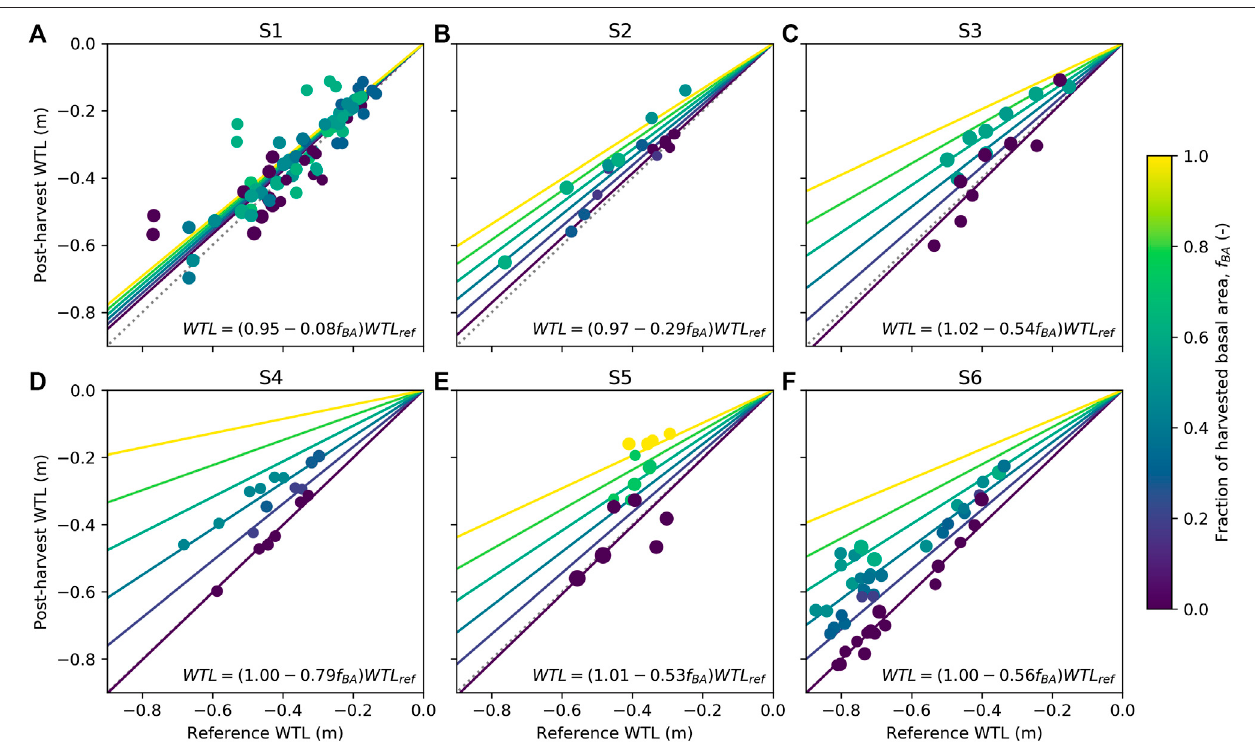
FIGURE5| Dependencyofpostharvestwatertablelevel(WTL)onreferenceWTL(see Eqs4and5 )forsitesS1 – S6 (A – F) .Thecolorsindicatetheharvestintensity andsymbolsizethepreharveststandbasalarea.DataarepresentedasmeanyearlyvaluesforJune – Octoberseparatelyforeachplotwithinasite.WTLpredictedbythe linear regression model (see Eq. 7 ) is shown for six different harvest intensities (line colors correspond to harvest intensities) and the 1:1 line is shown as dotted.